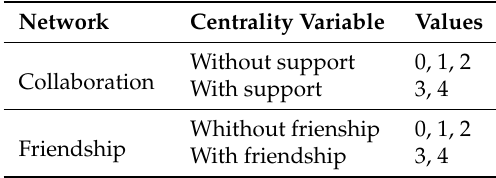
Table 2. Dichotomization of network